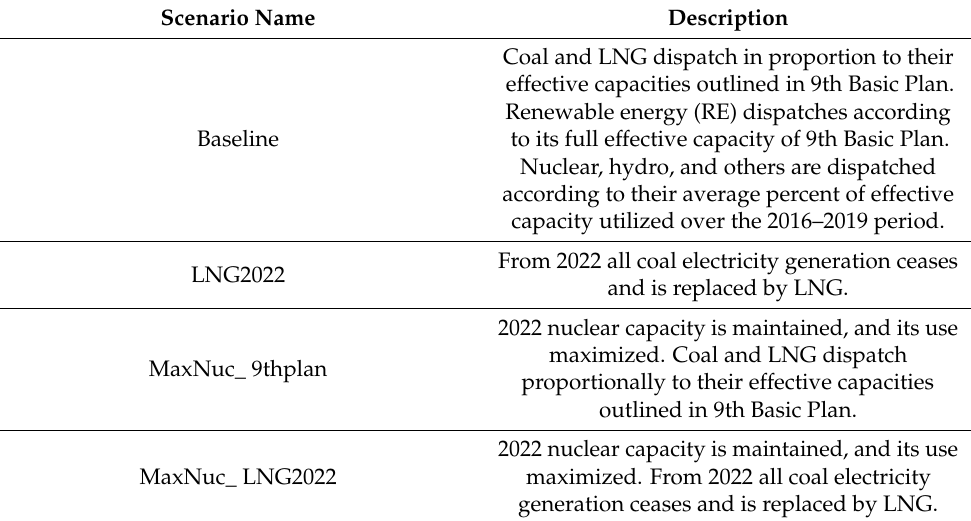
Table 1. Outline of scenarios.